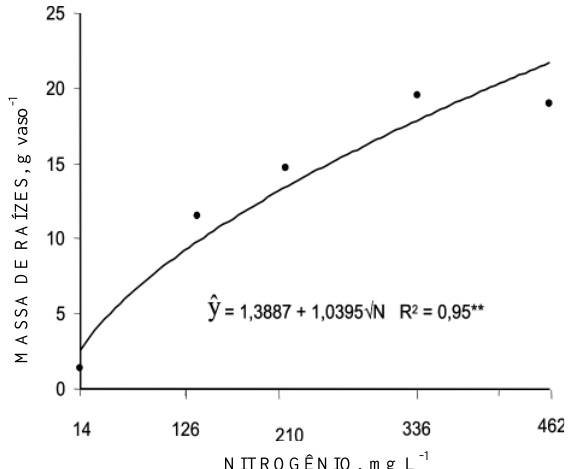
Figura 2. Produção de massa seca de raízes do capim- Marandu, considerando as doses de nitrogênio aos 79 dias do